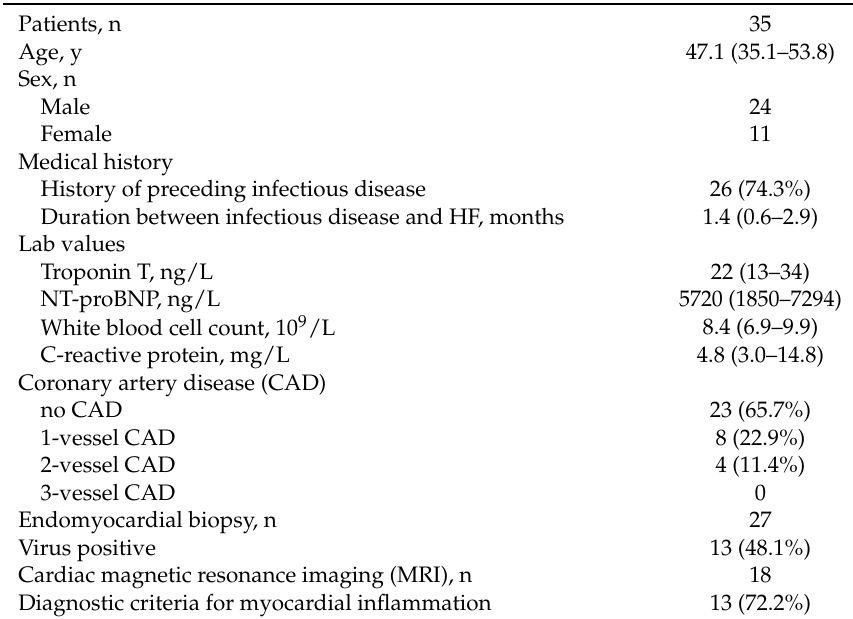
Table 1. Baseline characteristics at initial diagnosis of heart failure